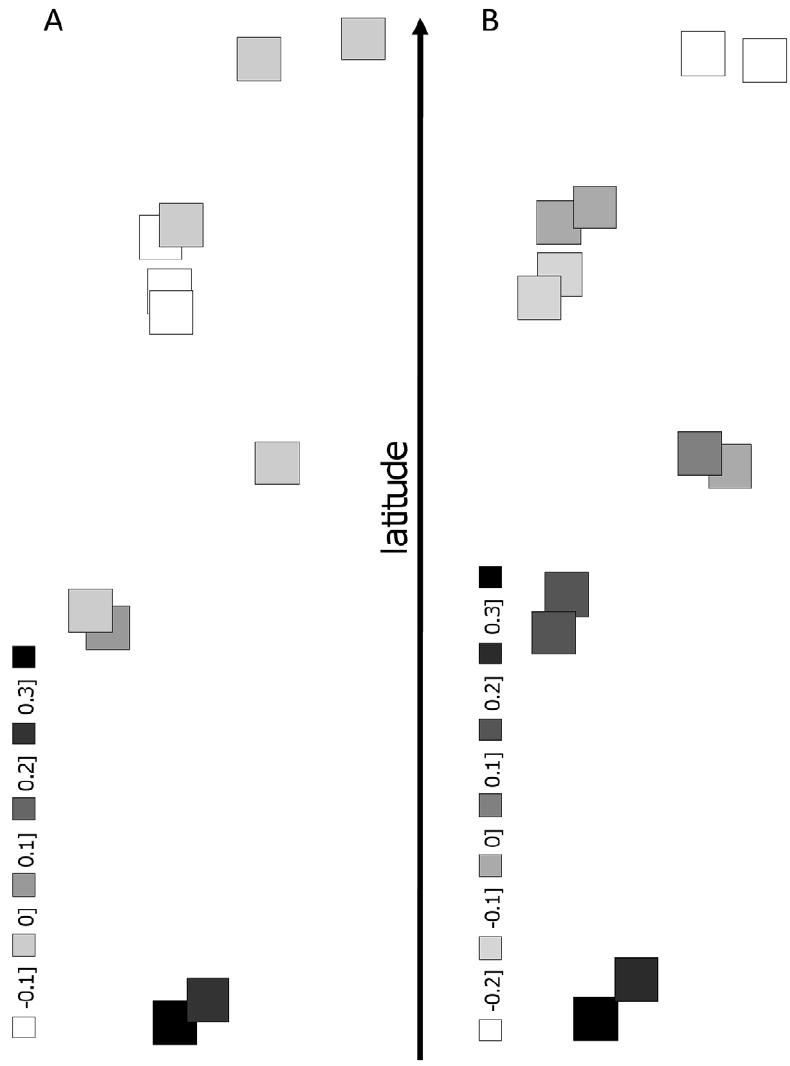
Figure 3. Spatial multivariate analysis. Squares represent first axis PCA scores of the A) agricultural and B) woodland populations and are placed according to their geographic coordinates. Large black squares correspond to high positive autocorrelation scores, whereas large white squares correspond to high negative scores. Gradual variation in autocorrelation scores represents clinal, isolation-by-distance genetic variation. Global scores were significant for woodland but not for agricultural populations (see text).